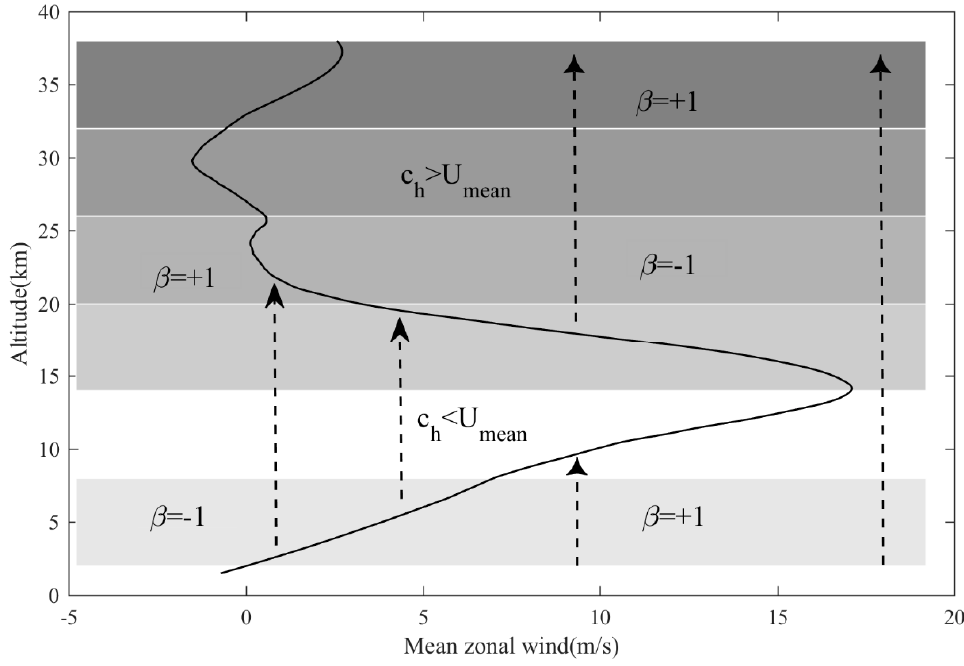
Figure 7. The mean zonal wind (solid line) observed from 21 September to 26 September over Hami. Dotted arrows represent gravity waves propagating upwards. The triangle arrow represents the waves for which c h > U mean , and the V-shaped arrow represents the waves for which c h > U mean . We use R to represent the ratio of spectrum kinetic energy to spectrum potential energy, which can be written as: